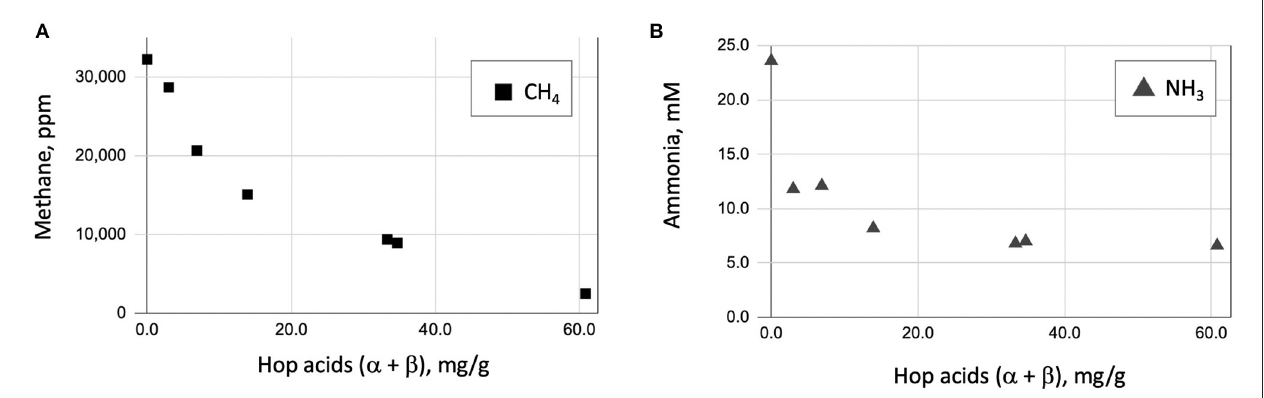
% Ammonia reduction